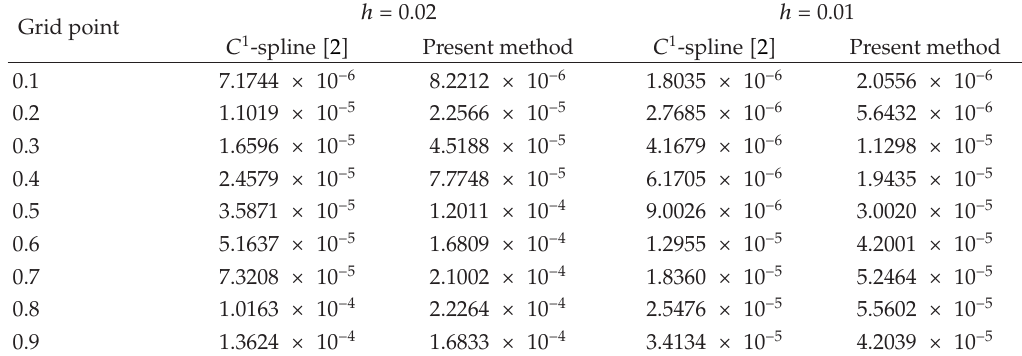
Table 3: Absolute error obtained with Δ t (cid:7) 2 h at T (cid:7) 2 for problem